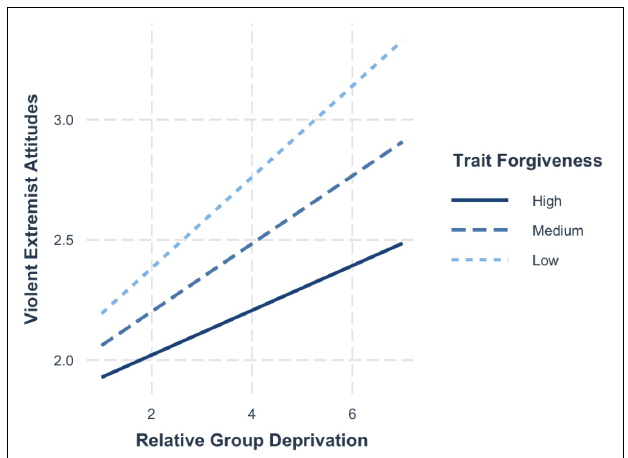
FIGURE 5 | Simple slopes for group deprivation and trait forgiveness on violent extremist attitudes.